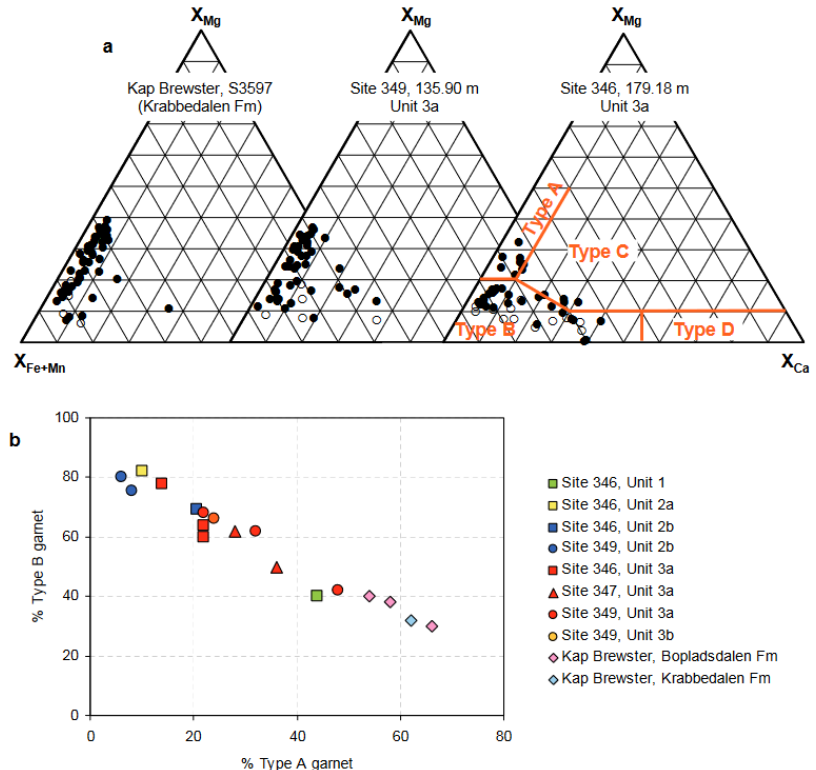
Figure 11. ( a ) Representative ternary plots of garnet compositions from the Jan Mayen Ridge and Kap Brewster. Fields A, B and C are as defined by Morton et al. [42]. X Fe , X Mg , X Ca , X Mn = proportions of Fe, Mg, Ca and Mn in the garnet formula with all Fe calculated as Fe 2+ . —X Mn < 5%. —X Mn > 5%. ( b ) Relative abundance of garnet types A and B in sandstones from the Jan Mayen Ridge and Kap Brewster.